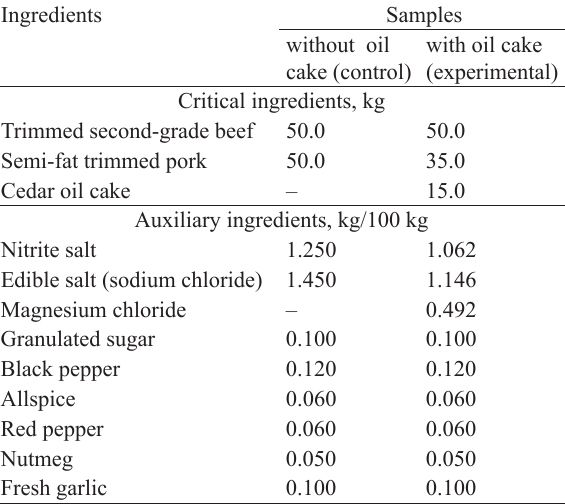
Table 1 Formulations of semi-smoked sausage